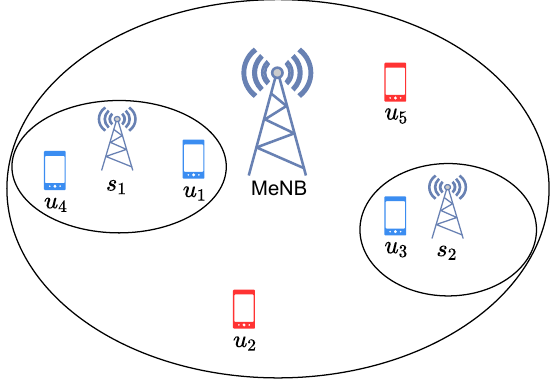
Figure 2. The network